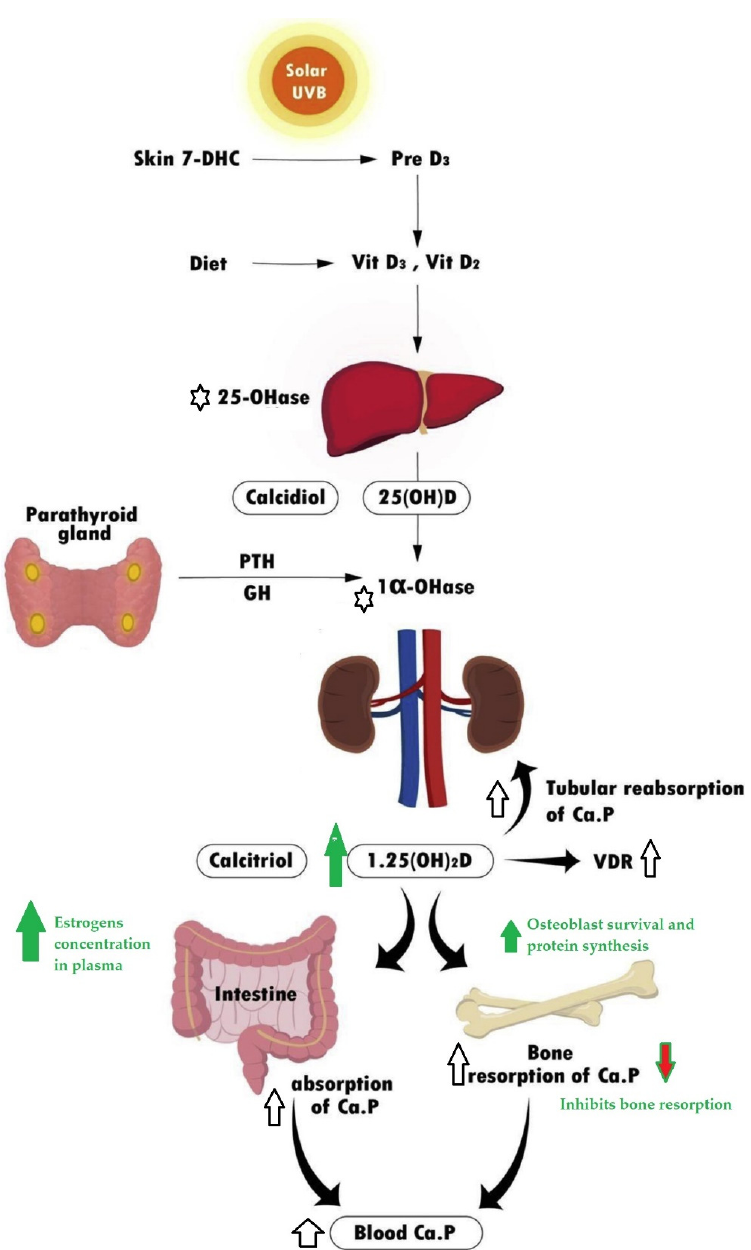
Figure 6. Some actions of BCC in VitD and its effects. The administration of boric acid, borax, or fructoborates increases calcitriol in plasma as well as some of its effects. However, these compounds inhibit bone resorption, which could be related with the increased levels of other steroid hormones.